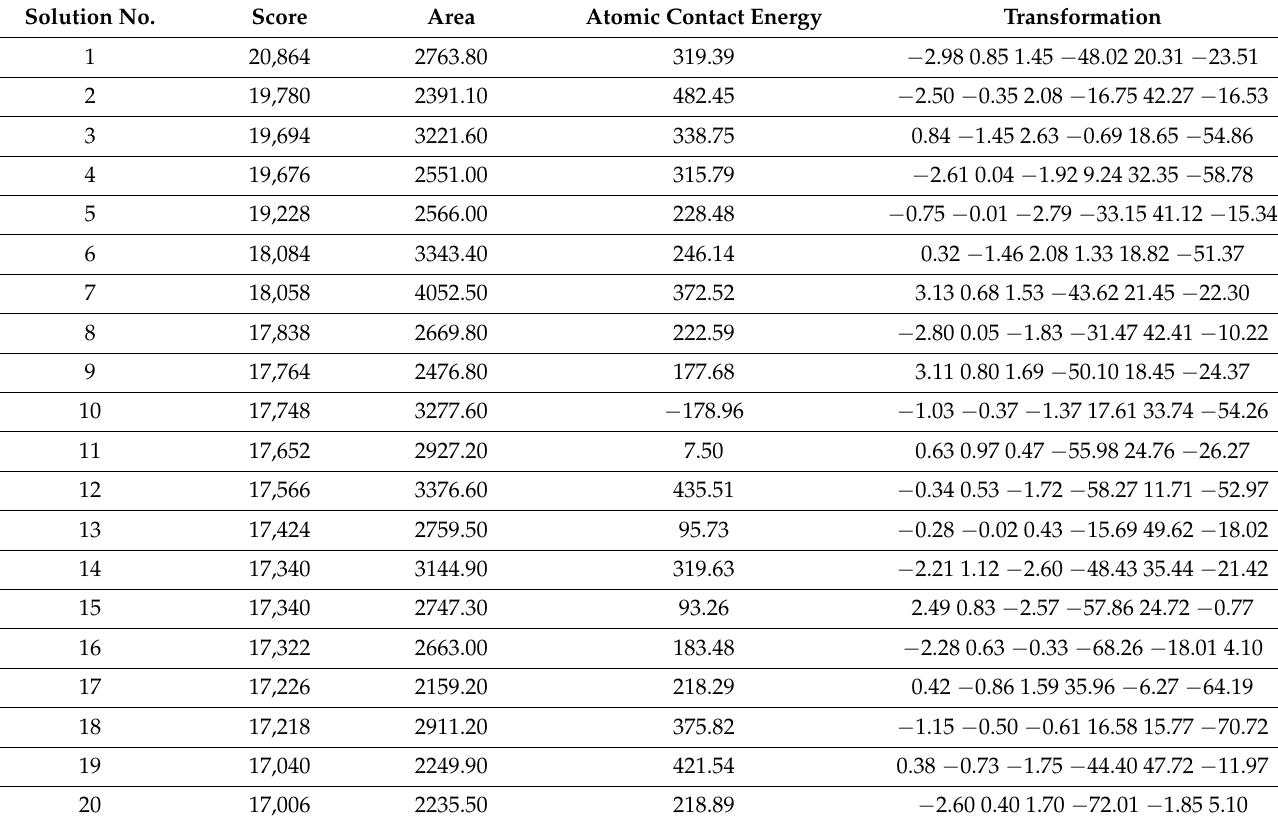
Table 10. Top 20 docking scores of the vaccine and TLR-4, generated by the PATCHDOCK webserver. Solution